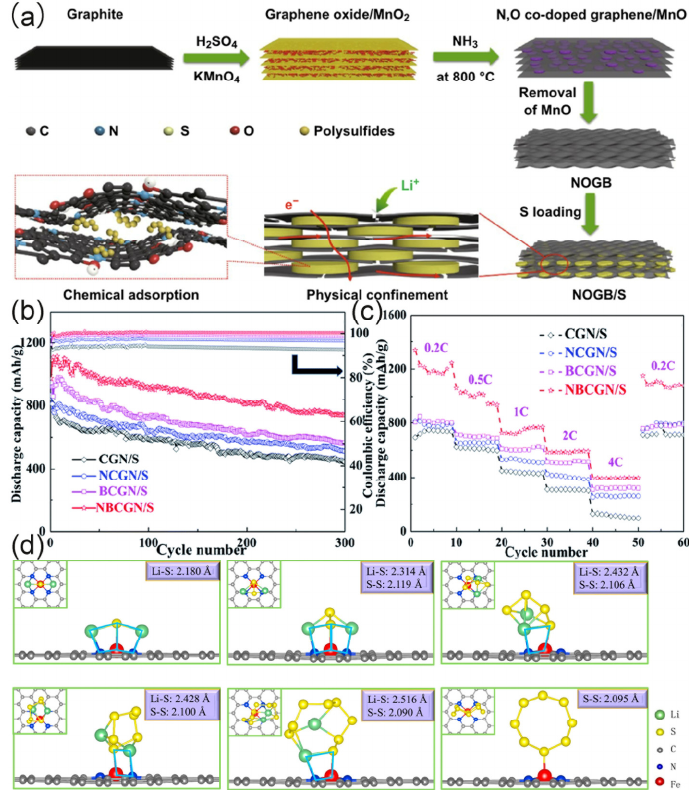
Figure 7. ( a ) Preparation process of the NOGB/S composite material [65]. Copyright 2020, Springer Nature. ( b ) Cycle performance and coulombic efficiency of electrode materials at 0.2 C. ( c ) Rate capabilities of different sulfur cathodes [64]. Copyright 2017, Royal Society of Chemistry. ( d ) Top and side view of the optimized lowest-energy adsorption configurations of Li 2 S n (n = 1, 2, 4, 6, 8) and S 8 on the FeN 4 @graphene surface [89]. Copyright 2019, Elsevier.